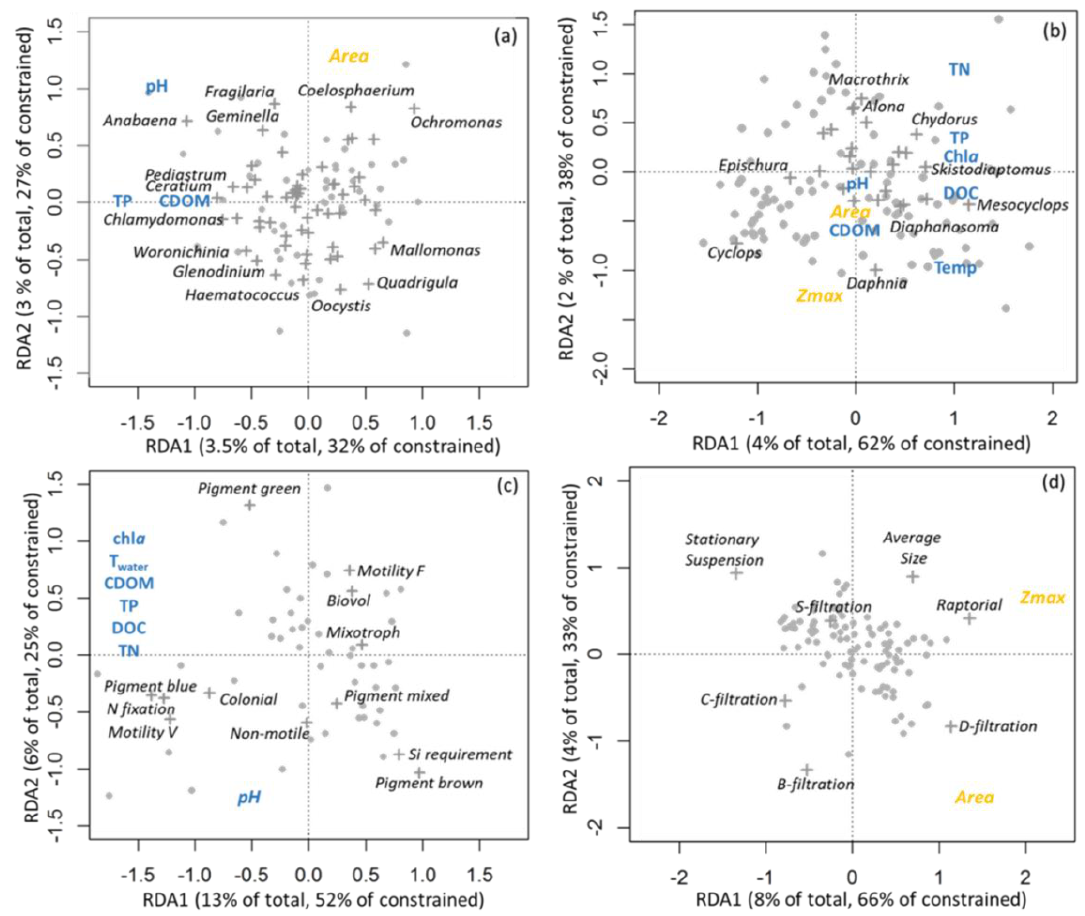
Figure 6: RDA ordination triplots of the (a, c) phytoplankton and (b,d) zooplankton composition classified by (a,b) taxonomy and (c,d) functional (c, d) traits. The RDA was constrained by environmental variables related to water quality (in blue) and by variables related to lake morphometry (in yellow). Taxa and functional trait response variables are represented by crosses and lakes by dots.s. In the taxonomic RDAs (a, b), only taxa with loadings over 0.20 are displayed. Abbreviations are as follows